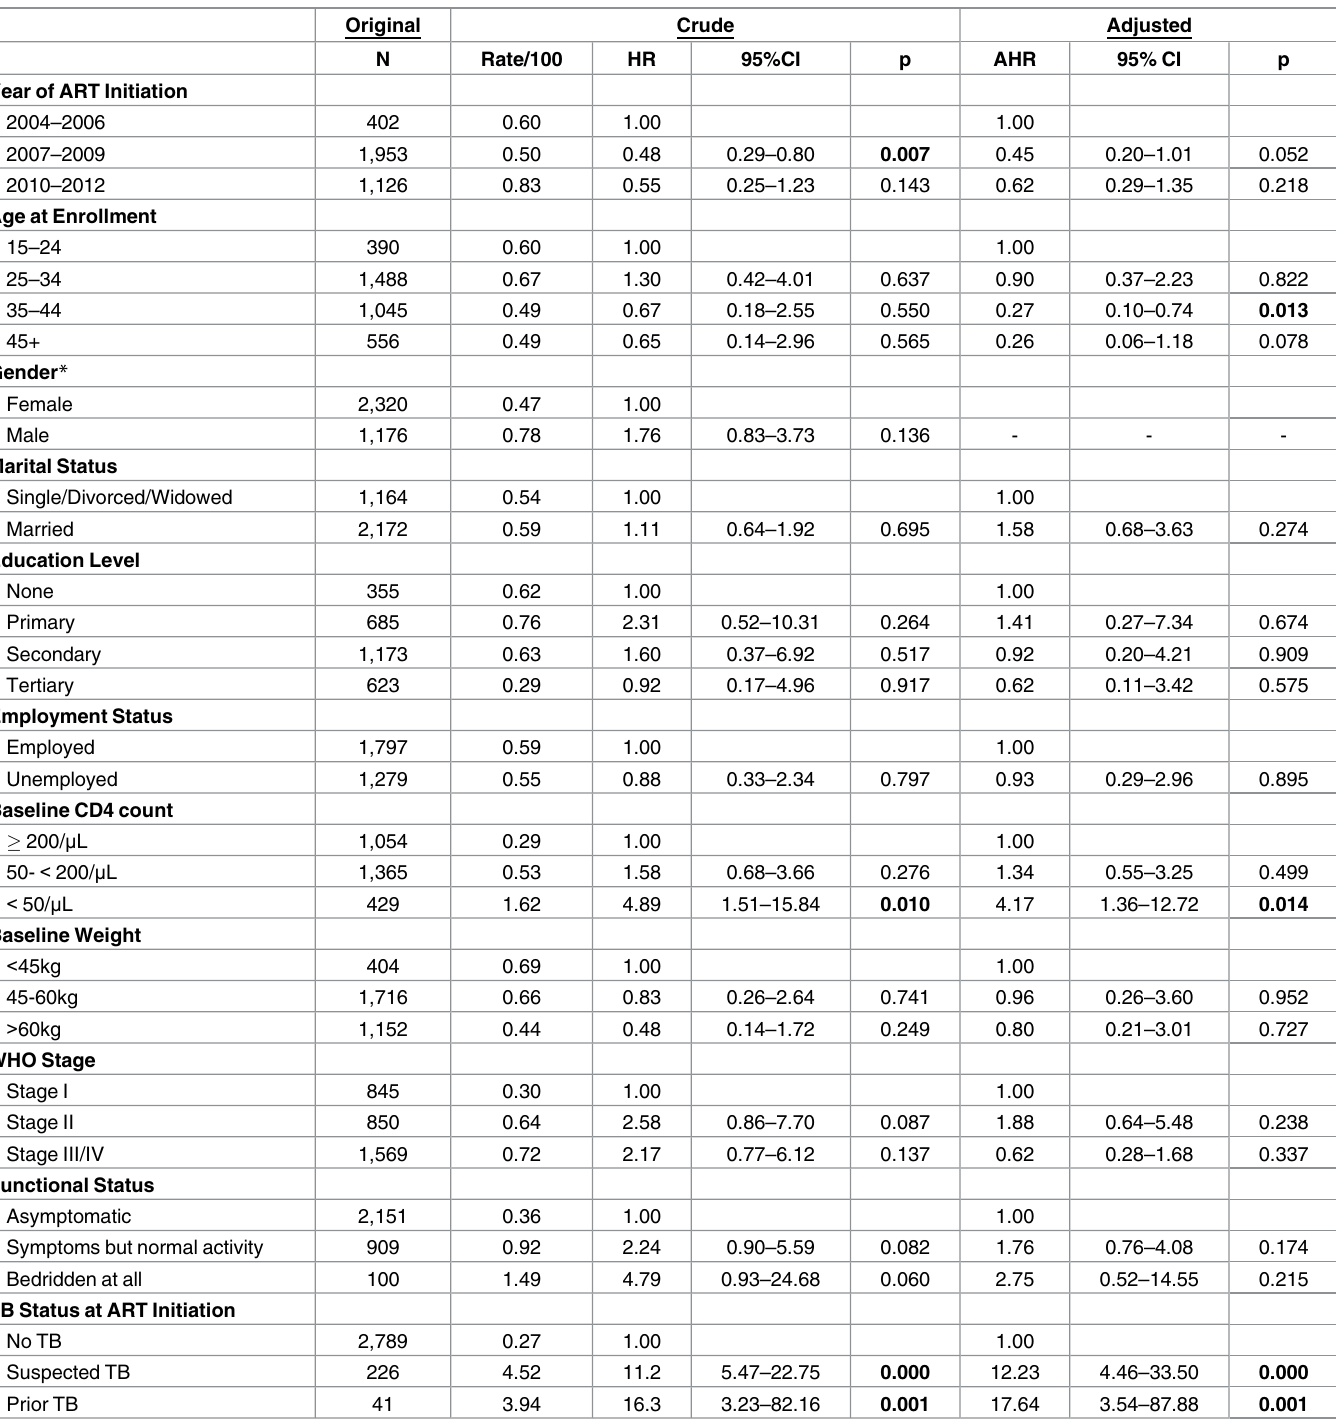
Table 2. Patient Characteristics Associated with TB Incidence after ART